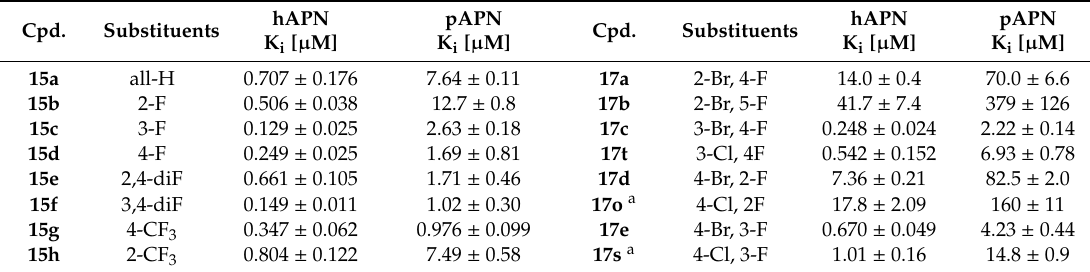
Table 1. Structures and inhibitory properties of the phosphonic acid analogues of homophenylalanine ( 15 ) and phenylalanine ( 17 ) towards human (hAPN) and porcine (pAPN) aminopeptidases.